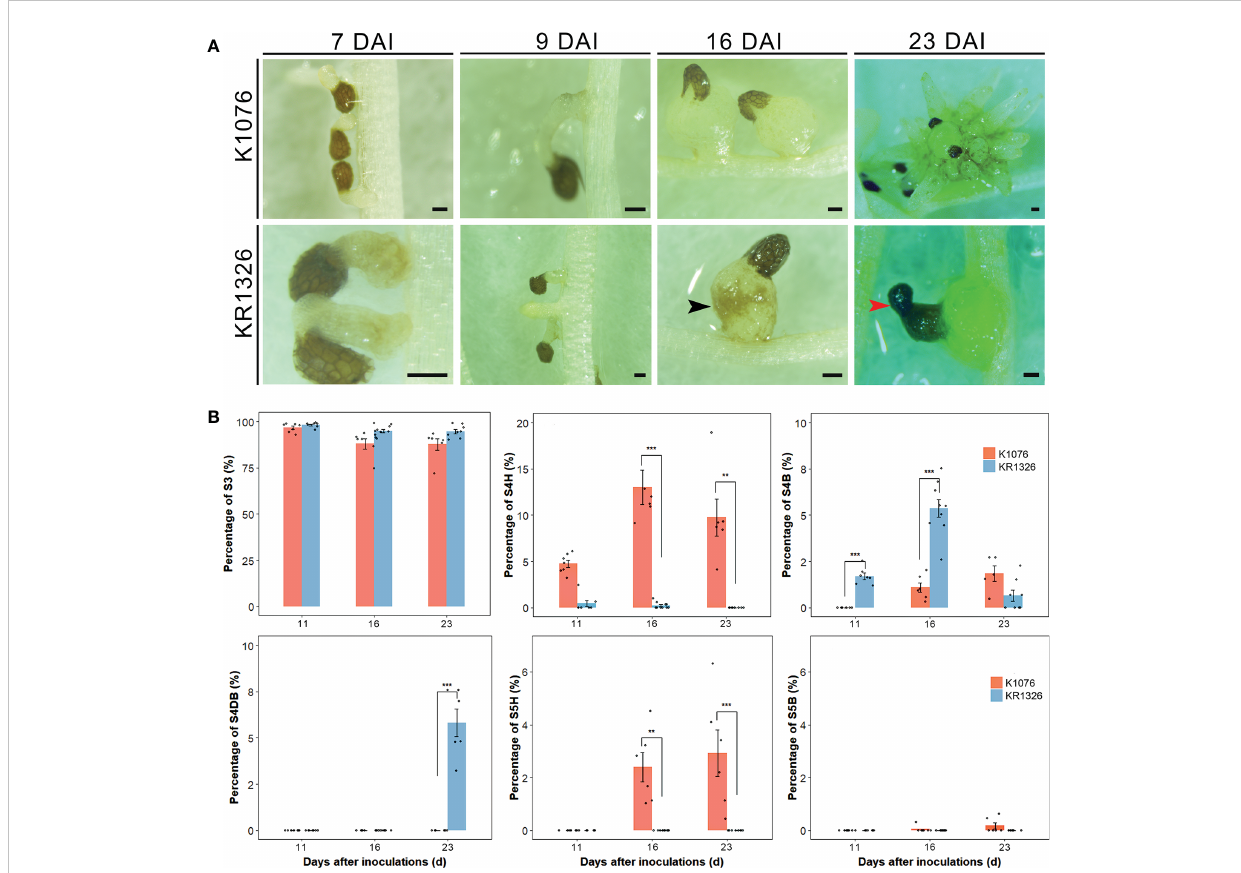
FIGURE 7 Differential response of K1076 and KR1326 to parasitism by P. aegyptiaca . (A) Representative photographs illustrating the phenotypic response of K1076, a susceptible cultivar, and KR1326 a resistant cultivar, to parasitism by P. aegyptiaca. Shown are the appearance of broomrape and the attachment sites at 7, 9, 16, and 23 DAI (the broomrape was in S2, S3, S4, and S5 stages, respectively). Bars = 200 m m. (B) Measured percentage of each different phenotypic event category during the interaction of P. aegyptiaca with resistant (KR1326) and susceptible (K1076) melon roots at 11, 16, and 23 DAI (n = 5~10). The abbreviation of the phenotypic event categories are as follows: S3, seeds had fi rmly adhered to or penetrated the host roots but had not formed a vascular connection; S4H, healthy tubercles; S4B, tubercle slight discoloration (black arrow); S4DB, tubercle severely browning or necrosis (red arrow); S5H, broomrape is healthy in the “ spider ” stage; S5DB, broomrape shows severe browning or necrosis in the “ spider ” stage. Data presented are means ± SE. *, **, *** indicate signi fi cant differences at P < 0.05, P < 0.01, and P < 0.001 respectively, by Student ’ s t test within a